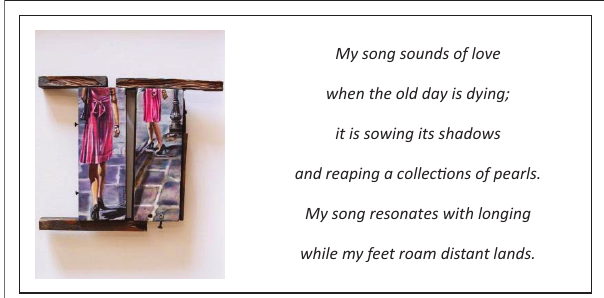
FIGURE 15: ‘The Forest Is Quiet All Around’.